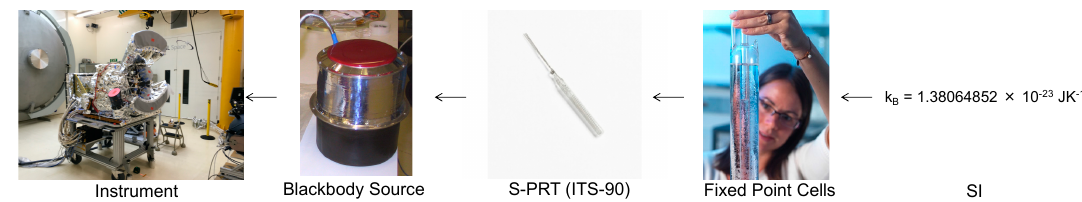
Figure 1. Illustrating the traceability of the SLSTR radiometric calibration via blackbody sources to ITS-90.